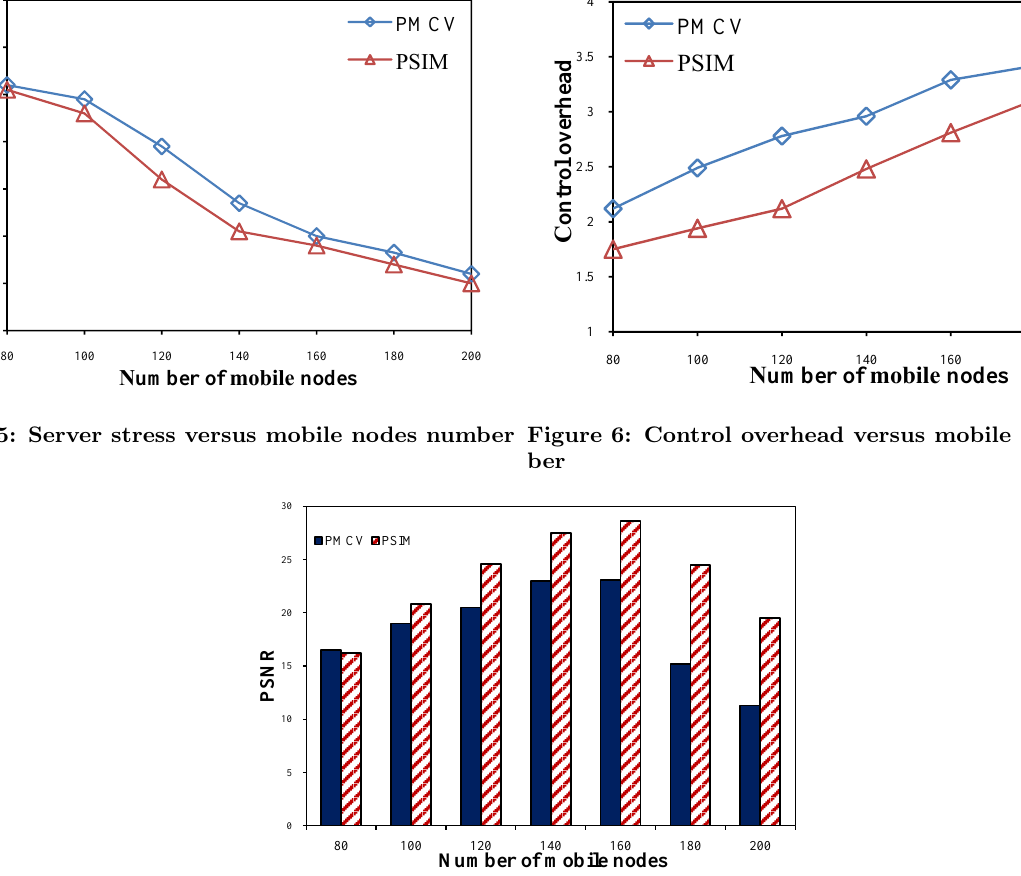
Figure 7: PSNR versus mobile nodes